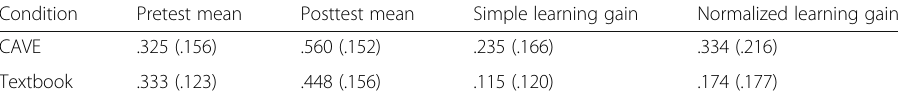
Table 2 Mean proportion correct pretest and posttest scores, as well as learning gains of CAVE and textbook conditions, with standard deviations in parentheses